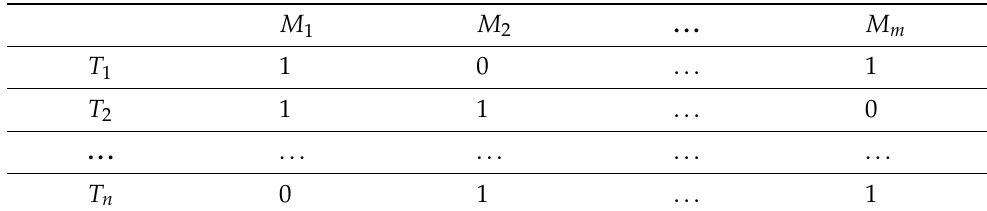
Table 1. Example of a test coverage matrix. T i indicate the i -th test case and M j indicates the j -th functional